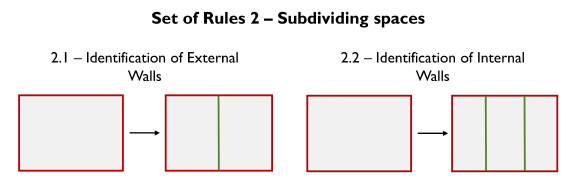
Figure 8. Grammar approach to subdivide spaces in the floor plan.